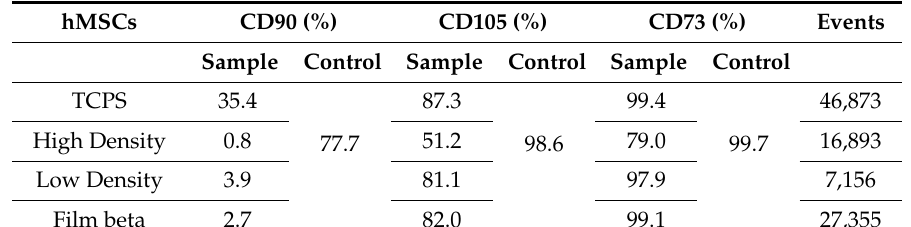
Table 2. Percentage of expression of the hMSC specific markers cultured on different biomaterials (TCPS, HD-M, LD-M and film-beta) compared with control at day 0 and number of events analyzed.